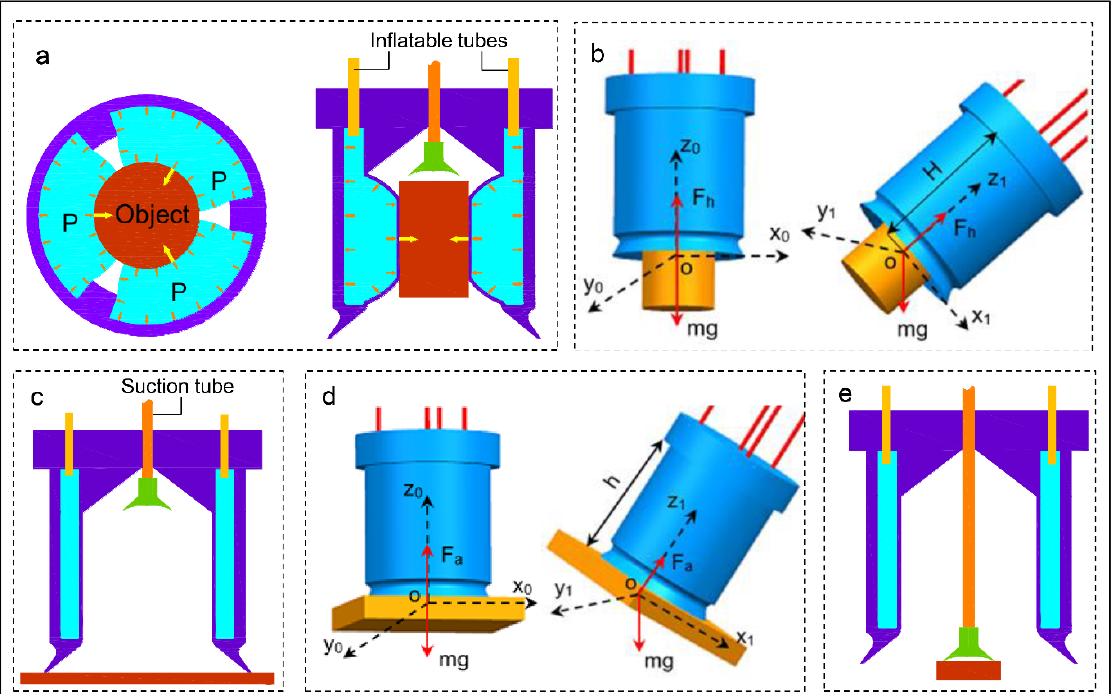
Figure 3. Schematic of the working principle of the novel combined soft gripper. ( a ) Schematic of grasping and holding of the cylindrical soft actuator. ( b ) Holding force analysis. ( c ) Schematic of adsorption of the cylindrical soft actuator. ( d ) Adsorption force analysis. ( e ) Schematic of adsorption of the detachable sucker.